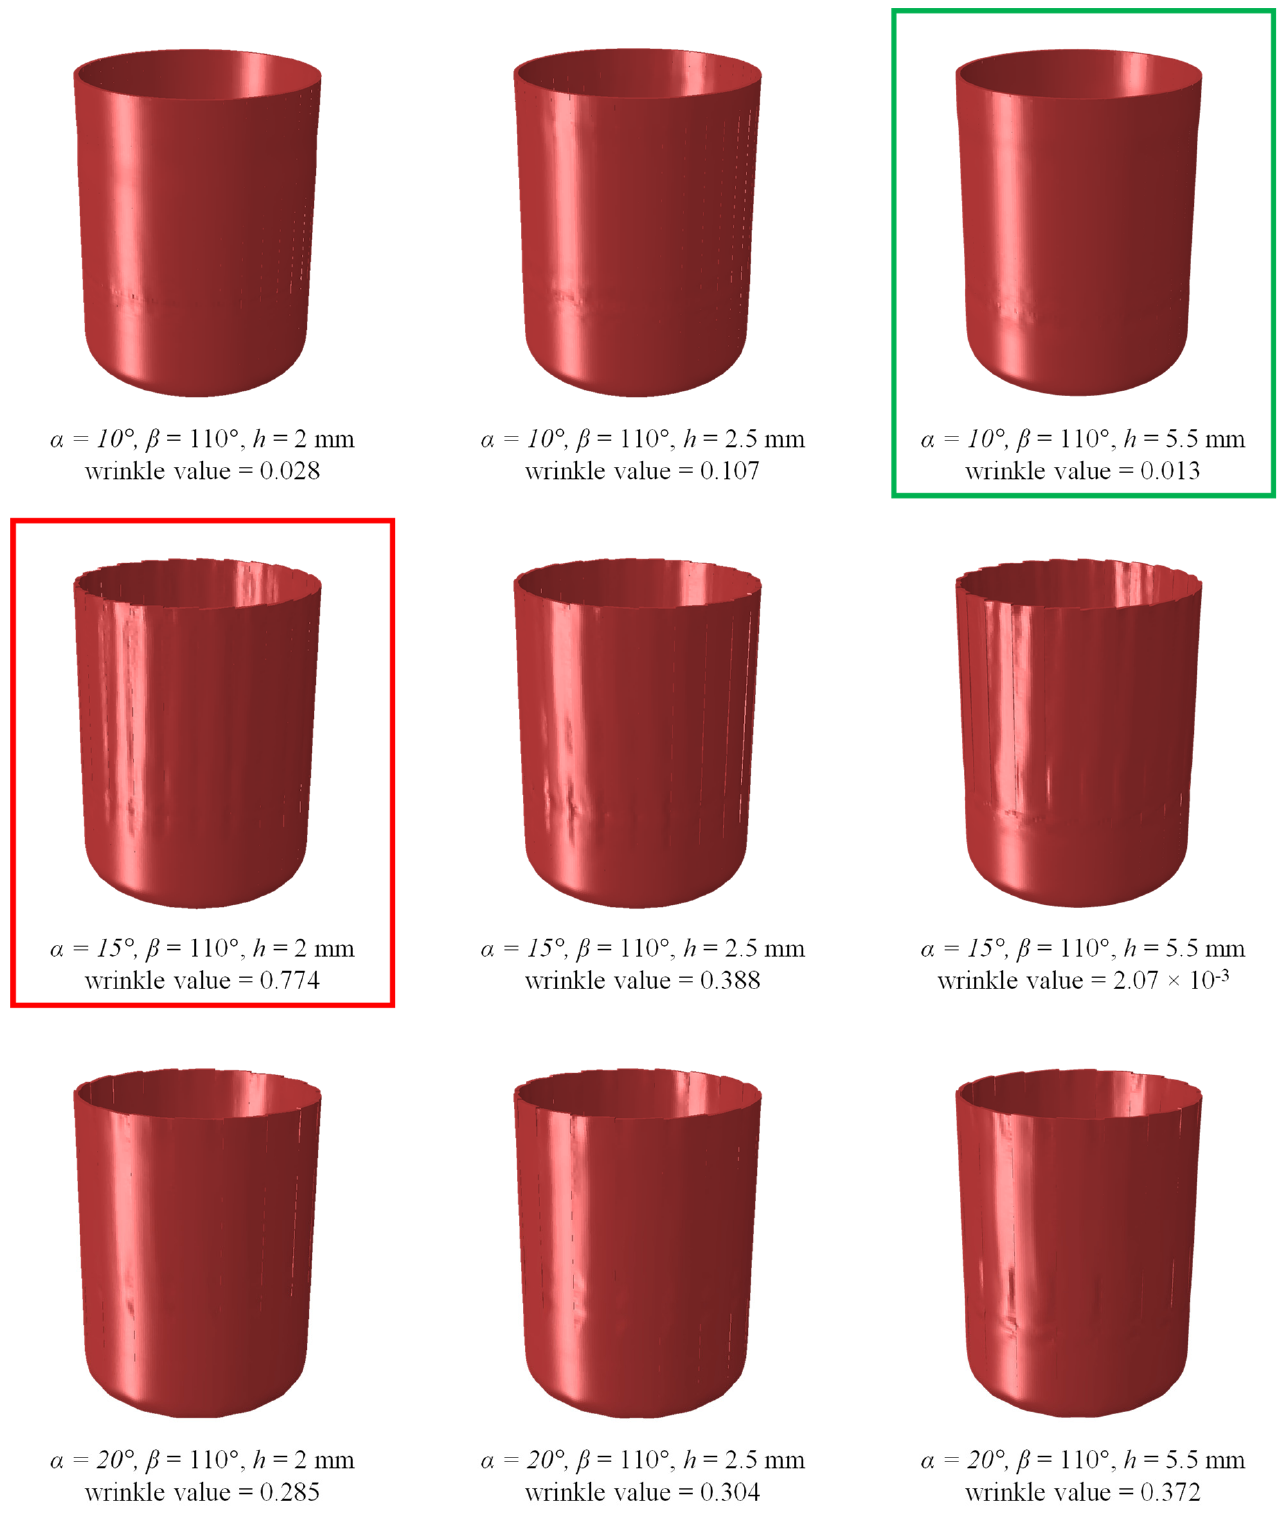
Figure 14. Wrinkle value as a function of the channel outlet geometry of the die. It is noticeable that all cups have visually visible wrinkles. This can be explained by an analysis of the lubricant film (see Figure 15). Small SPH particles are moved downwards with the sheet metal. The gap between stamp and die is 0.65 mm and the sheet metal before forming is 0.42 mm. Since the SPH particles have an element size of 0.15 mm and cannot be deformed, the sheet metal is inevitably deformed, which leads to increased wrinkling.